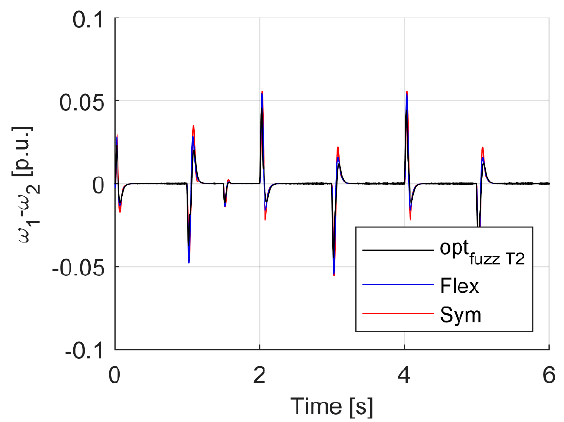
Figure 17. Transients of difference between motor and load speed for analyzed controller cases.